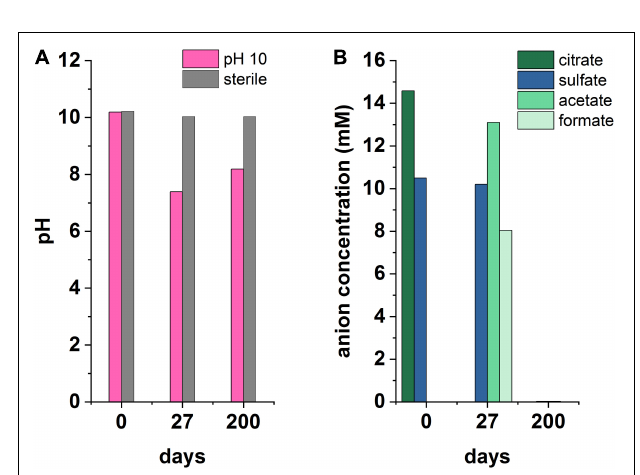
FIGURE 4 | Recorded pH (A) and anionic species (B) measurements from an anaerobic, pH 10 microcosm under sulfate-reducing conditions, incubated for 200 days at 20 ◦ C in the dark.